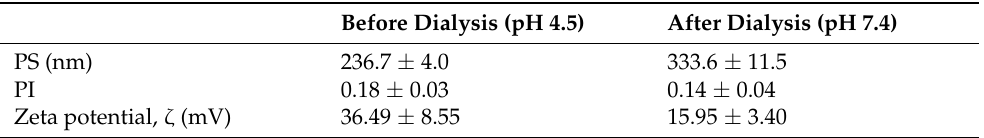
Table 1. CS-NPs mean particle size (PS, nm), polydispersity index (PI) and zeta potential ( ζ mV) (mean ± s.d.; n = 3) before and after